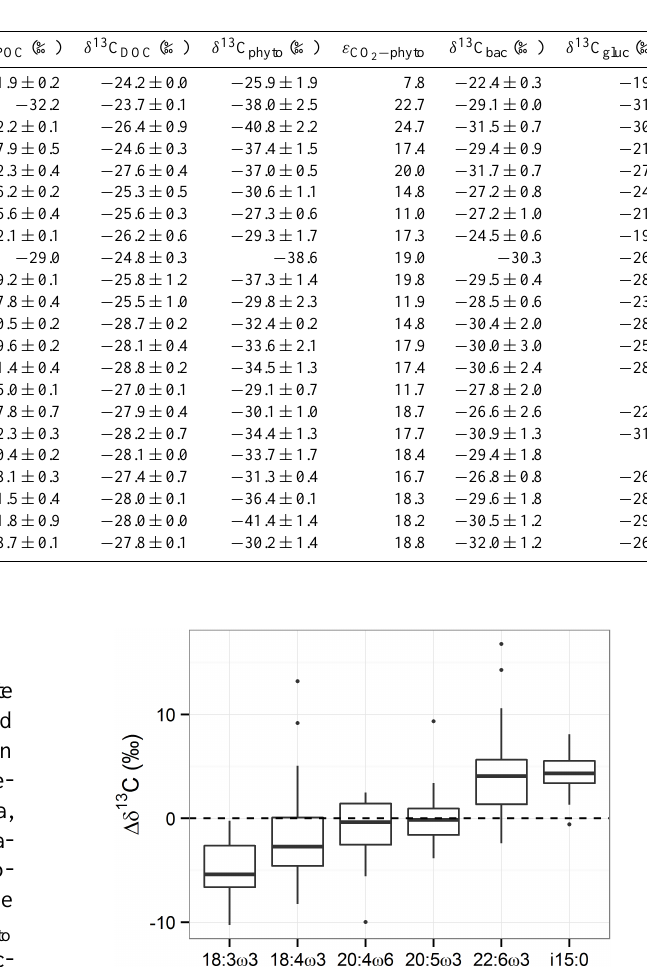
was calculated from δ 13 C DIC 2 (Eq. 2) used the corrected 2 − phyto